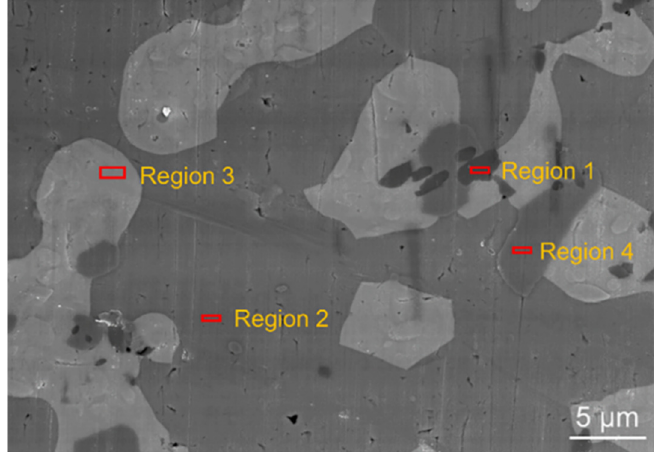
Figure 7. Local magnification SEM image of the fully mixed solder joint. Table 2. Element content of the regions marked in Figure 7.